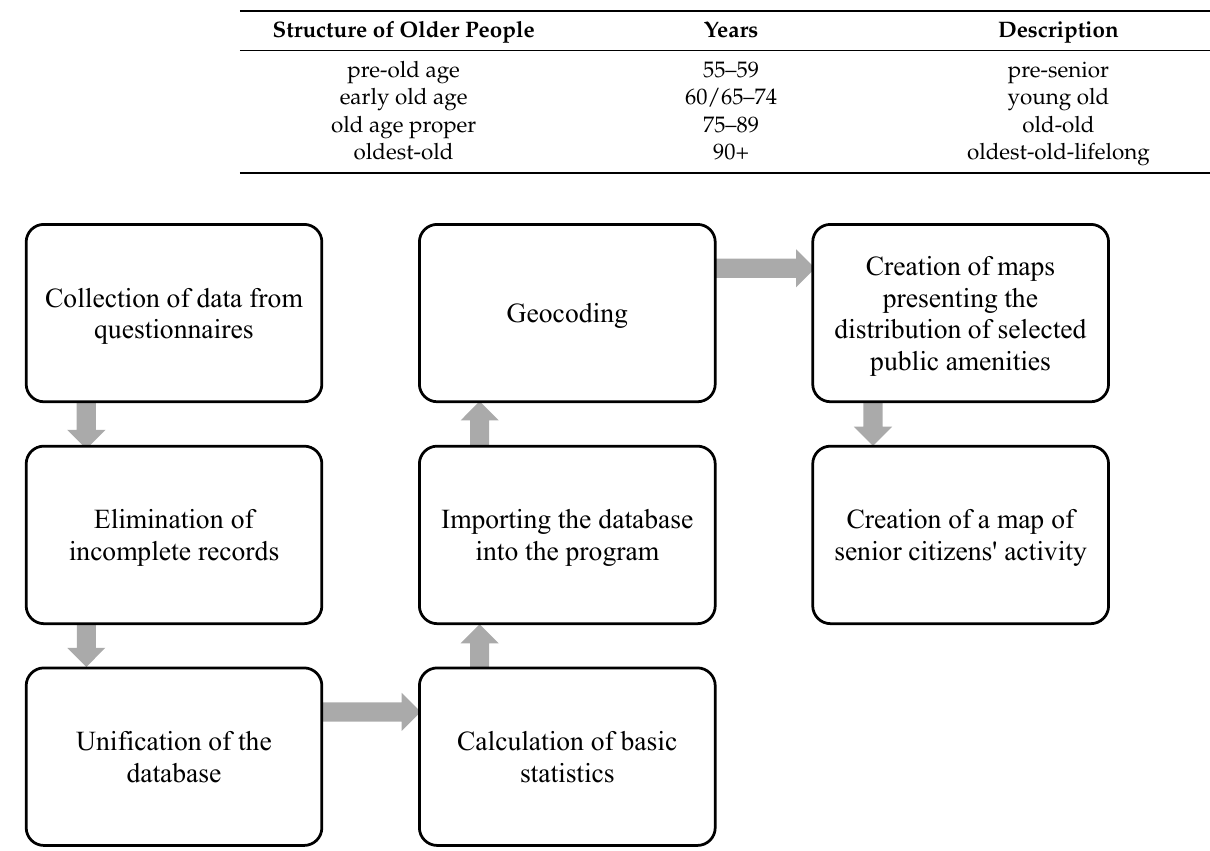
Figure 2. Procedure of preparing and analyzing the data for Olsztyn. Source: own elaboration.